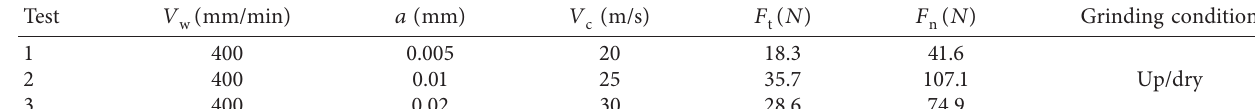
Table 2: Experimental input parameter and values of measured grinding forces.